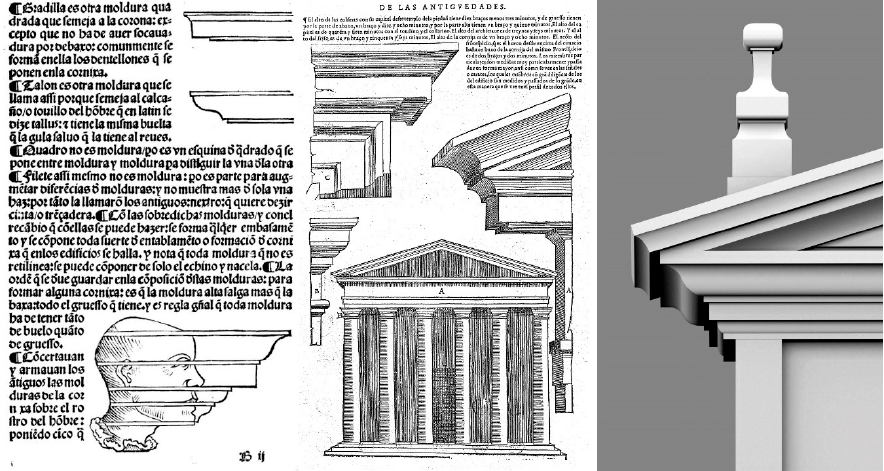
Figure 5. To the left , illustrations of the second chapter of Medidas del Romano , by Diego de Sagredo, which explains how the cornice should be formed and what the mouldings that compose it are. In the centre are models of the Tercero y quarto libro de Architectura by Serlio [19]. To the right are details of the proposed virtual reconstruction of the Porta Miñá Fountain. The image was provided by the authors.